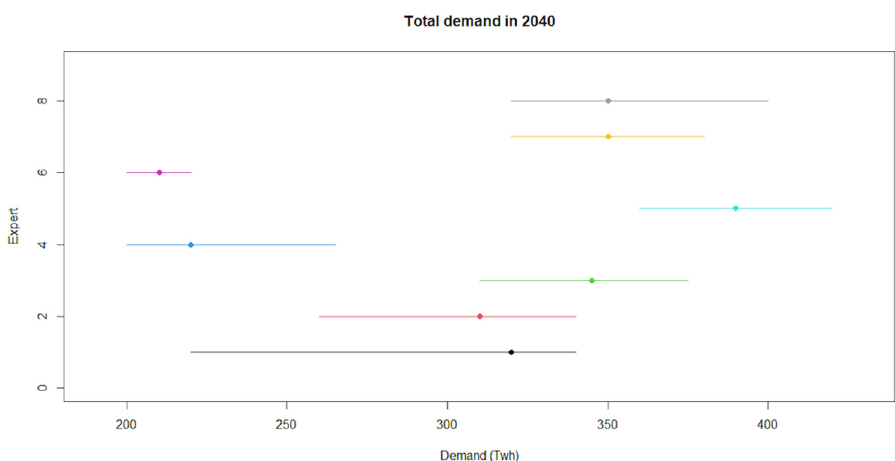
Figure 3. Interquartile range of total electricity demand in 2040 for the 8 participants. Each line represents the lower quartile to upper quartile, and dot is the median, of the elicited estimates for each participant.